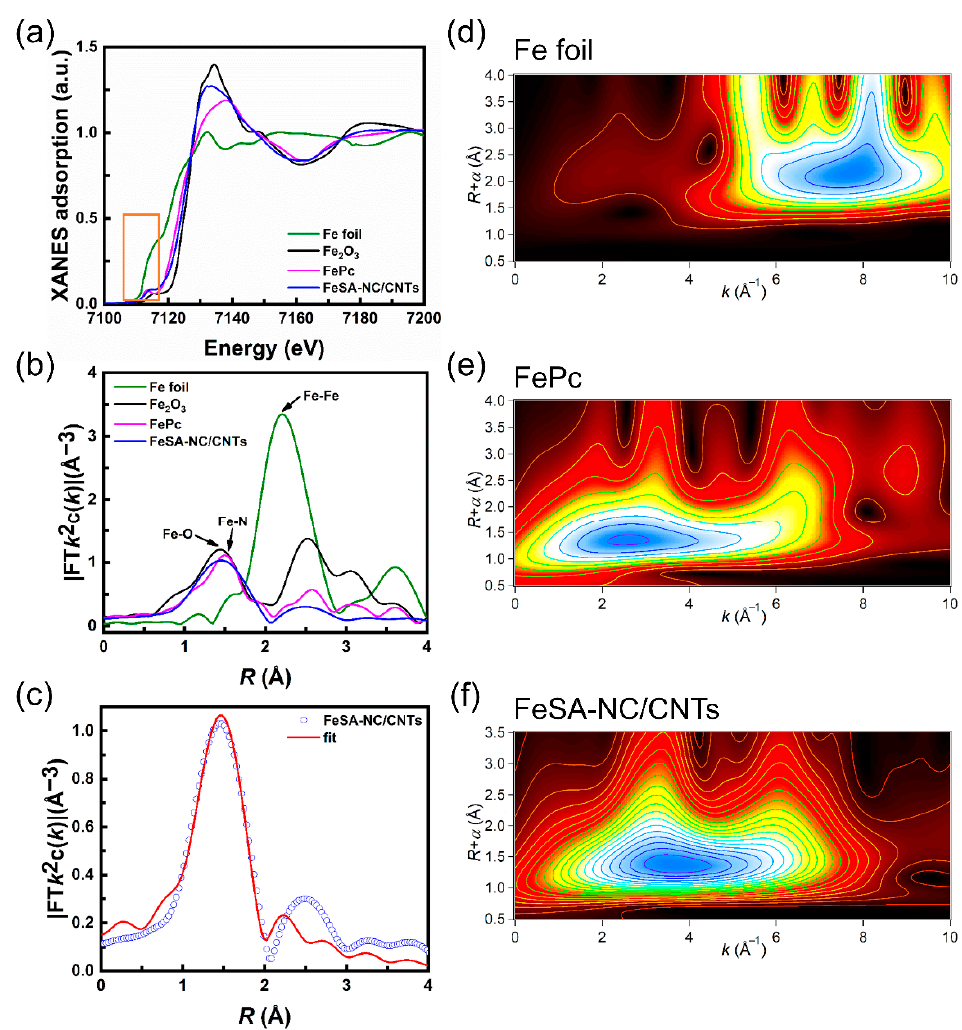
Figure 4. ( a ) Fe K-edge XANES spectra of FeSA-NC/CNTs (the orange area highlights the near-edge absorption energy). ( b ) Fourier transform (FT) of the Fe K-edge EXAFS spectra. ( c ) The corresponding EXAFS r space fitting curves of FeSA-NC/CNTs. Wavelet transform (WT) of Fe K-edge for ( d ) Fe foil, ( e ) FePc, and ( f ) FeSA-NC/CNTs.